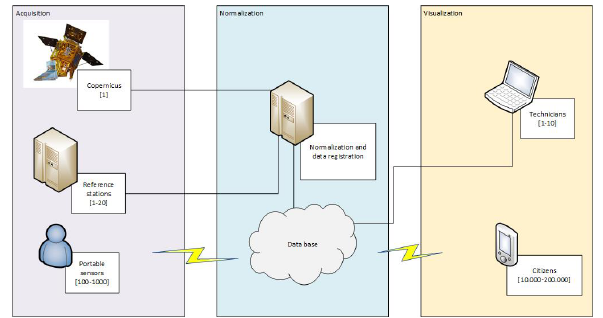
Figure 1. Architecture of the Crowd-sourced Air Quality Monitoring